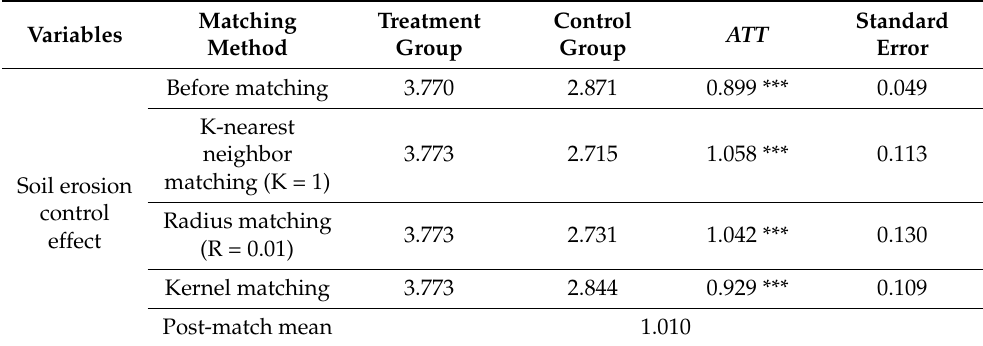
Table 3. The net effect of residents’ participation in the cultural tourism industry influencing soil erosion control